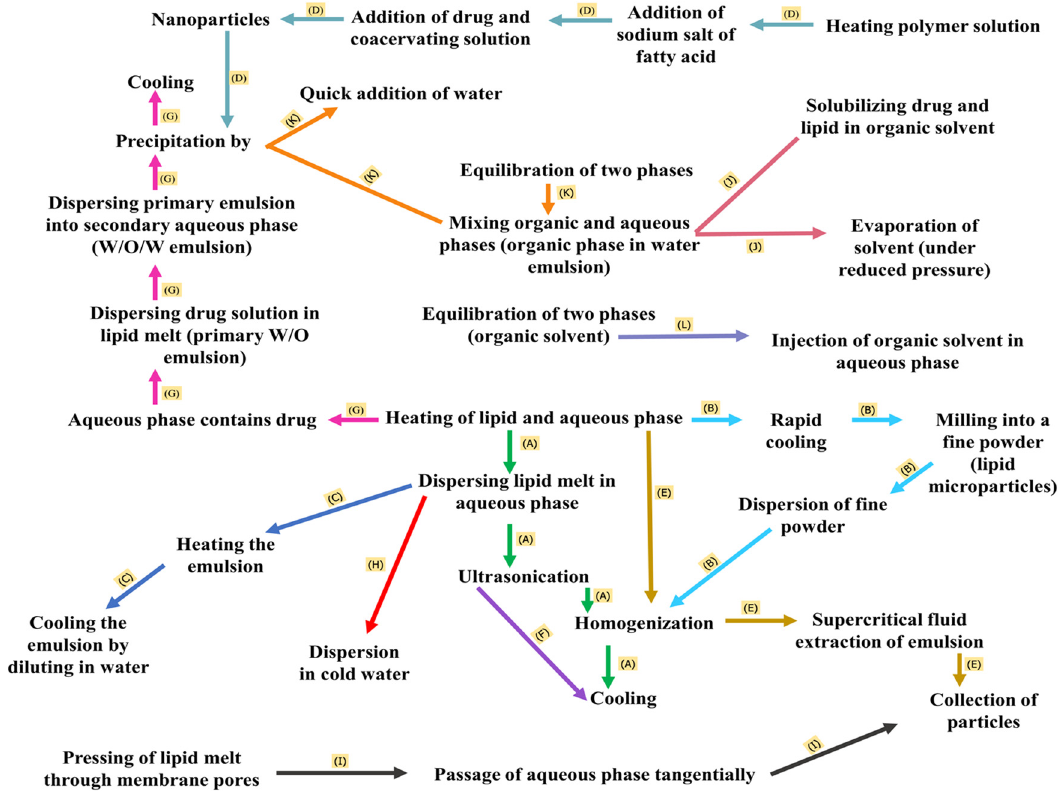
Figure 1: Methods of preparation of NLCs. ( a ) Hot homogenization technique, ( b ) cold homogenization technique, ( c ) phase inversion temperature ( PIT ) technique, ( d ) coacervation technique, ( e ) supercritical fl uid ( SCF ) technique, ( f ) high shear homogenization/ultraso - nication technique, ( g ) double emulsion technique, ( h ) microemulsion technique, ( i ) membrane contactor technique, ( j ) emulsi fi cation – solvent evaporation technique, ( k ) emulsi fi cation solvent di ff usion technique, and ( l ) solvent injection